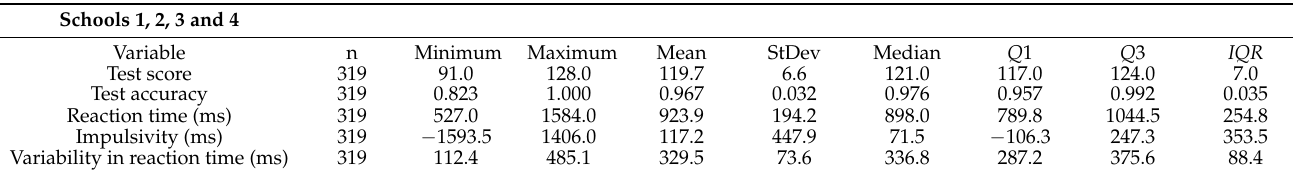
Table 1. Descriptive statistics (mean of pre-post) for the five responses considered in this research work. Schools 1, 2, 3 and 4